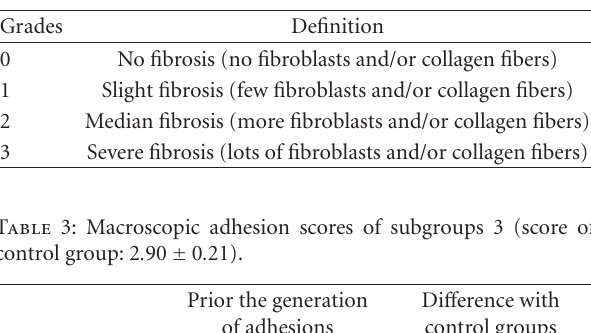
Table 6: Microscopic adhesion values of subgroups 4 (value of control group: 2 . 80 ± 0 .